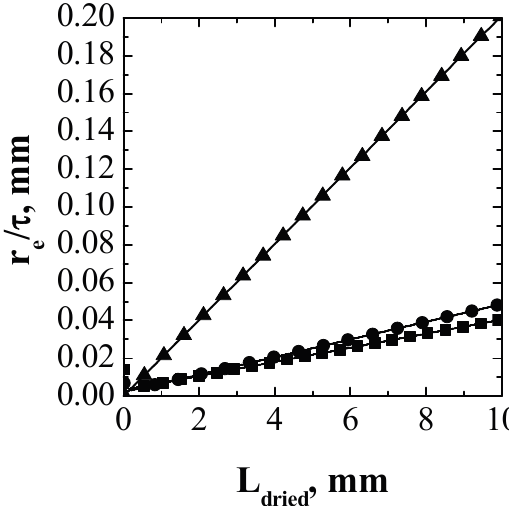
Figure 4. Cake structures at 1 mm from the top obtained by Scanning Electron Microscope in the run I ( A ); run II ( B ); and in the run III ( C ).